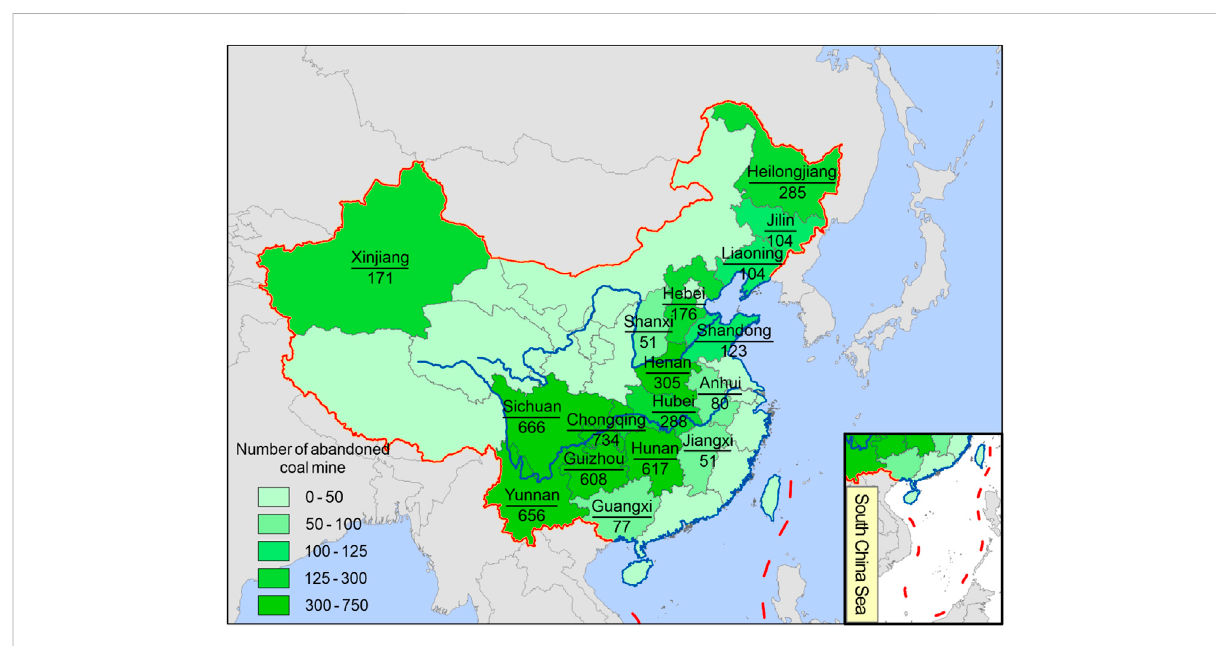
FIGURE 1 Distribution of abandoned coal mines in China during the years 2014 –